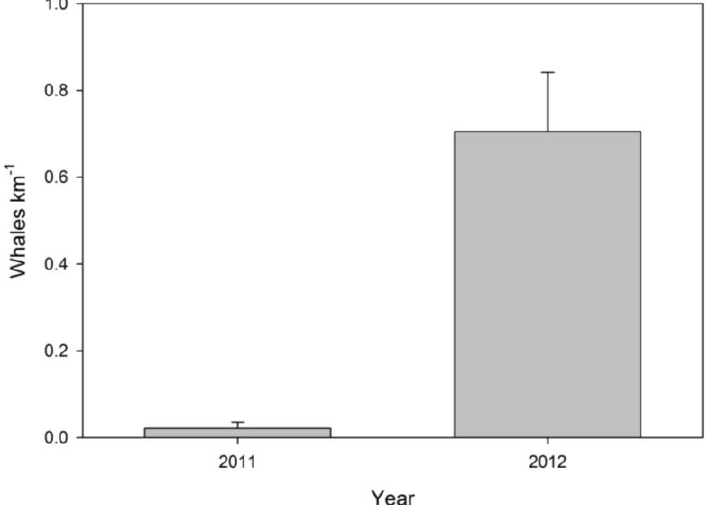
Figure 5. Mean number of whales (±S.E.) sighted per km of